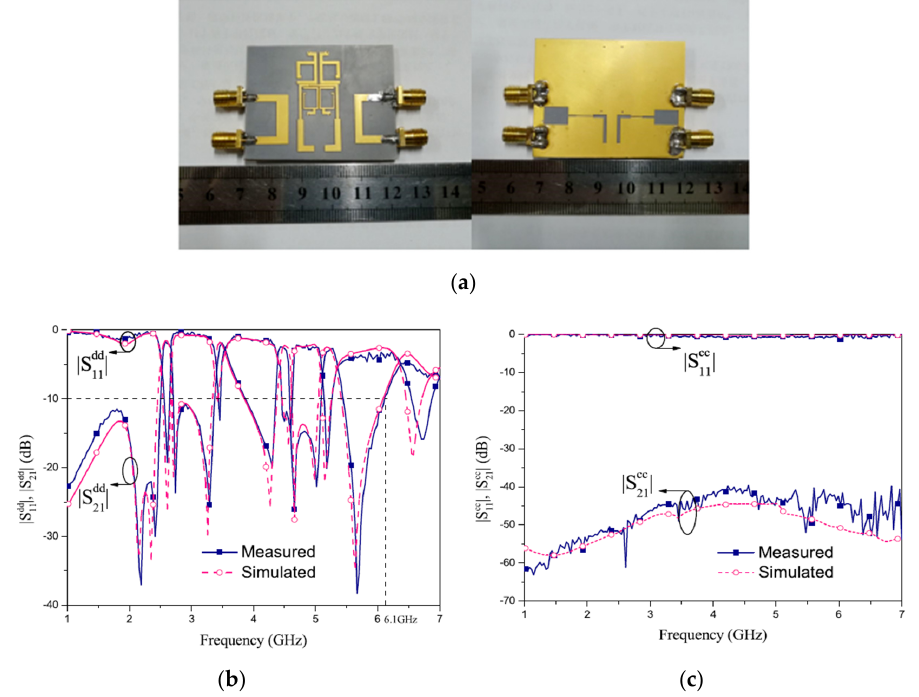
Figure 17. The proposed balanced quad-band BPF [78]: ( a ) Photograph of the fabricated prototype; ( b ) Differential-mode performance; ( c ) Common-mode performance. Table 3. Performance comparisons for some recent tri- and quad-band differential microstrip BPFs. Ref.